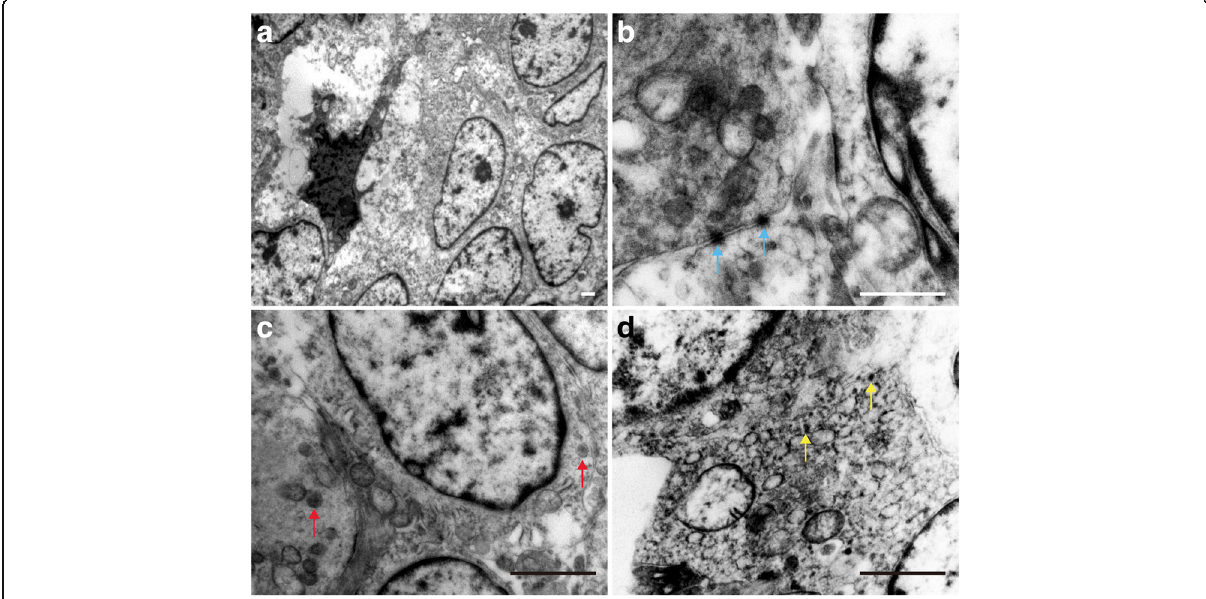
Fig. 5 Ultrastructure analysis of the tumor. a At lower magnification, EM shows the general tumor ultrastructure. b Cell-cell gap junctions ( blue arrow) were observed in some areas. c Neurosecretory granules ( red arrow) were rarely seen in the tumor cytoplasm. d Glycogen granules ( yellow arrow) existed in most tumor cells. All bars = 2000